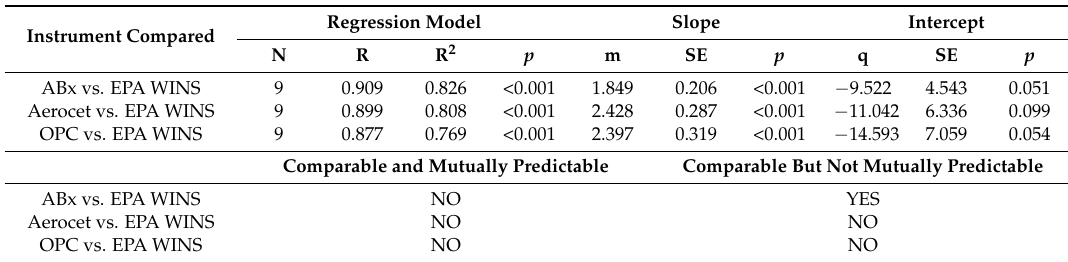
Table 8. Regression parameters between direct-reading instruments (8-h averaged data) and the gravimetric method. N: number of data; R: Pearson correlation coefficient; p : significance; m: slope; q: intercept; SE: standard error.